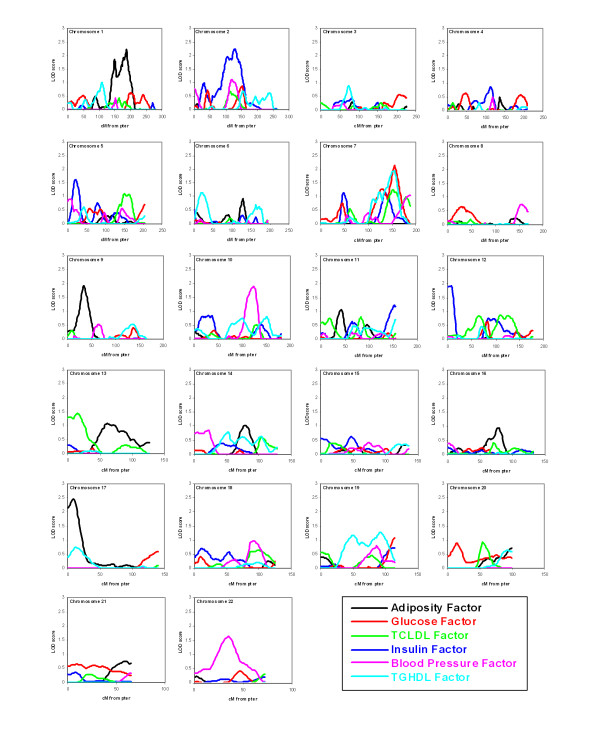
Multipoint linkage analyses results of the six factors. The horizontal axis is cM from p-terminus.